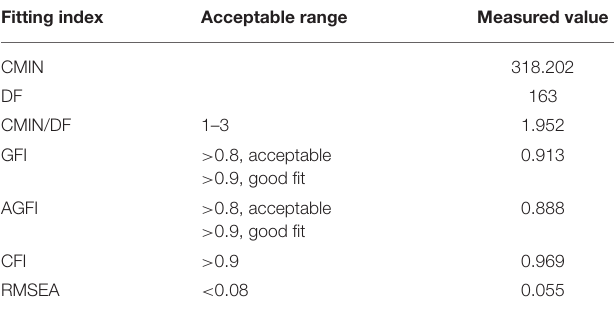
TABLE 3 | Structural equation model fit